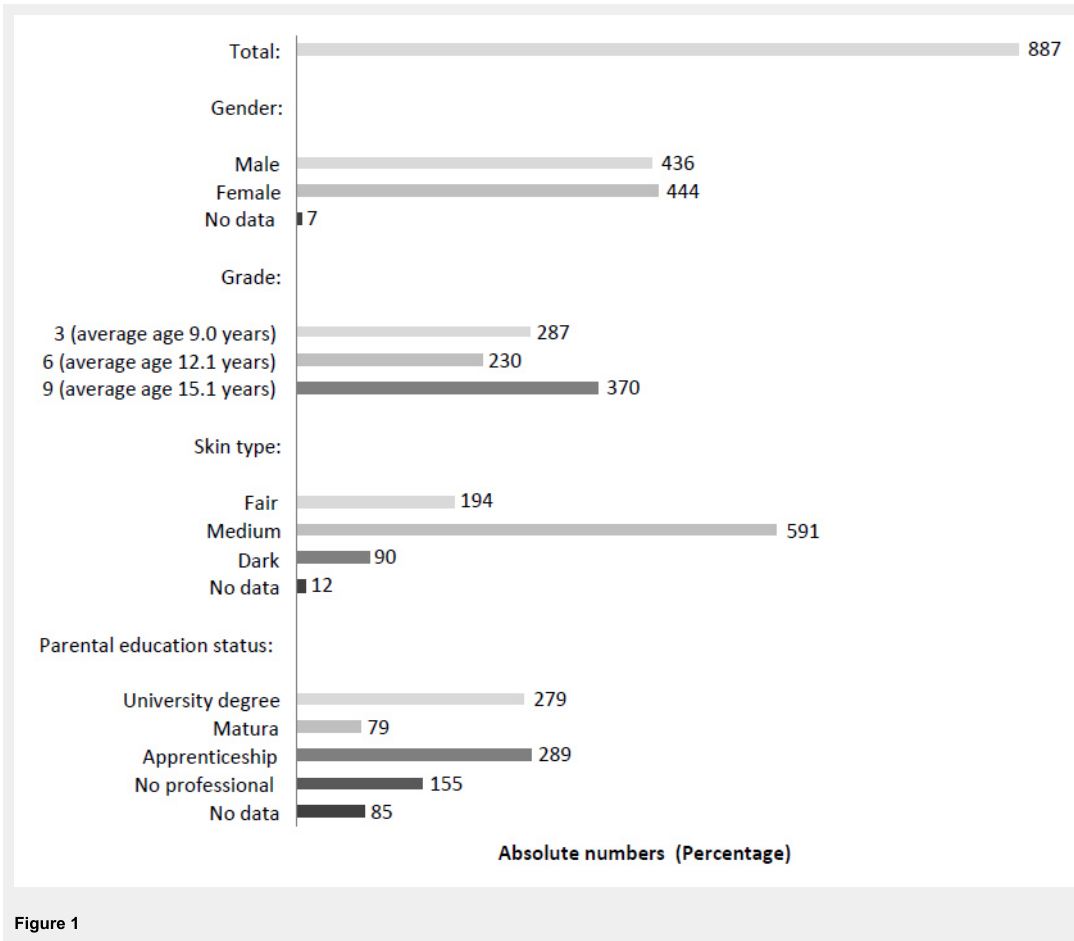
Characteristics of the study